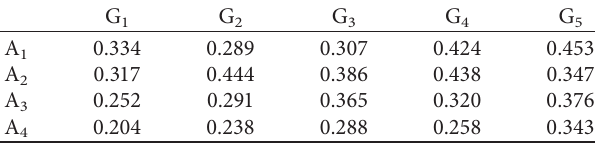
Table 5: Values of attribute comprehensive decision in